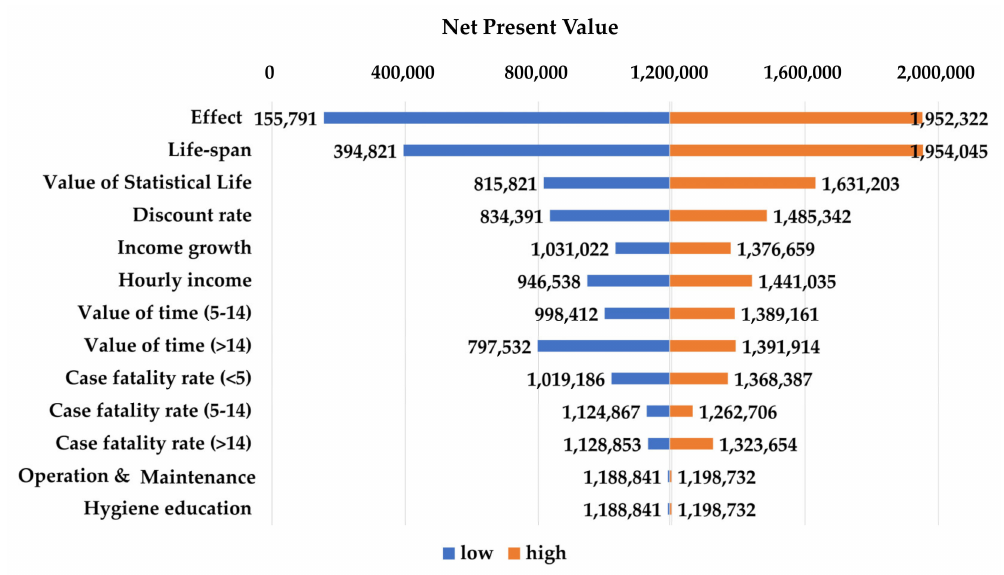
Figure 4. Results of the one-way analyses (net present value in 2016, Int’l $).